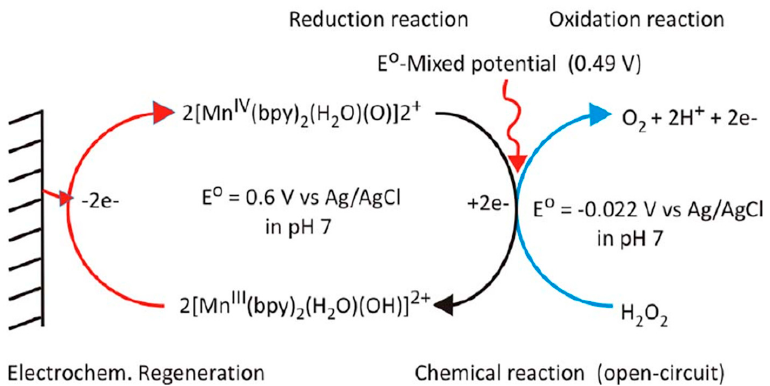
Figure 9. Mechanism of the Mn Ⅳ / Ⅲ mediated electrode process [86]. Copyright: Elsevier B.V.